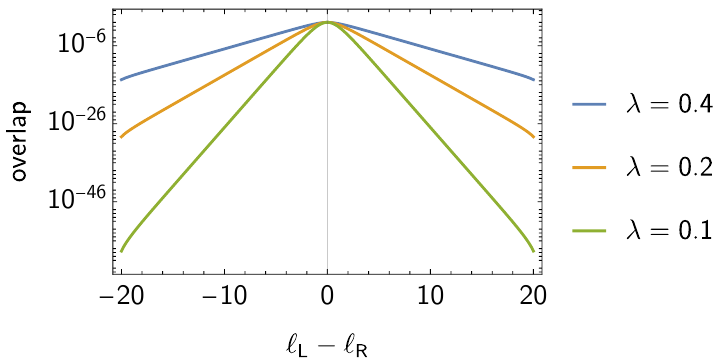
Figure 8 . The normalized overlap (3.5) between the symmetric state | n, n i and the asymmetric state | n L , n R i . We keep ‘ = λn fixed and consider different λ . We set r = 1 / 2 . If we were to plot the overlap as a function of n instead of ‘ , the curves would appear in reverse order.